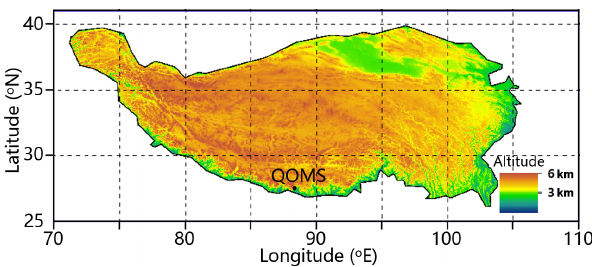
Figure 1. Elevation map of the TP and location of the CAS (QOMS) monitoring